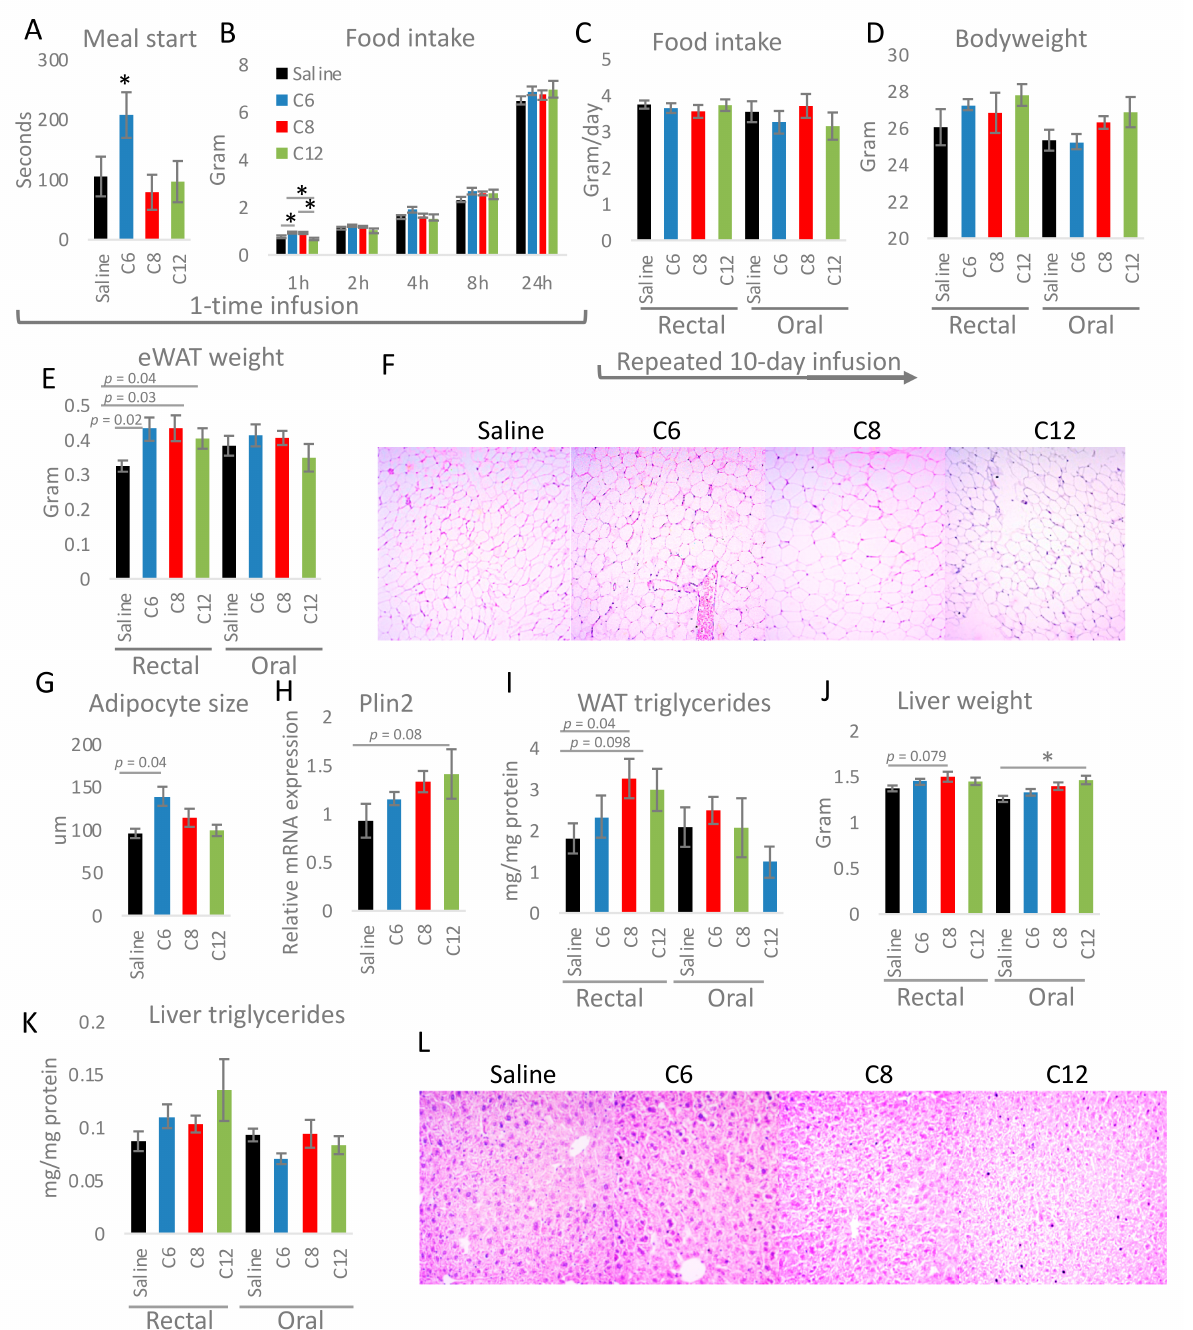
Figure 3. Rectal infusion of MCFA results in changes in epididymal WAT weight, adipocytes size, and lipid accumulation. The speed of meal initiation ( A ) and accumulative food intake over 24 h ( B ) was measured following one-time rectal fatty acid (FA) or saline infusion. Food intake ( C ), body weight ( D ), and epididymal WAT weight ( E ) were compared between animals infused daily rectally or orally with FAs or control solution over 10 days. Adipocyte size was quantified based on hematoxylin & eosin histology staining ( F , G ). The mRNA expression of perilipin 2 (Plin2) ( H ) and WAT triglycerides content ( I ) were quantified in mice infused with FA and saline. Liver weight ( J ) and triglycerides content ( K ) were measured for animals infused rectally or orally with FA or control solution. Liver histology was performed to compare lipid accumulation in animals submitted to different treatments ( L ). Statistical significance between the experimental groups was evaluated using ANOVA with Bonferroni correction for multiple testing; n = 4–8 for ( G ), n = 6–8 for ( I , K ), n = 8 for other panels; * p < 0.05. Data are presented as mean ±